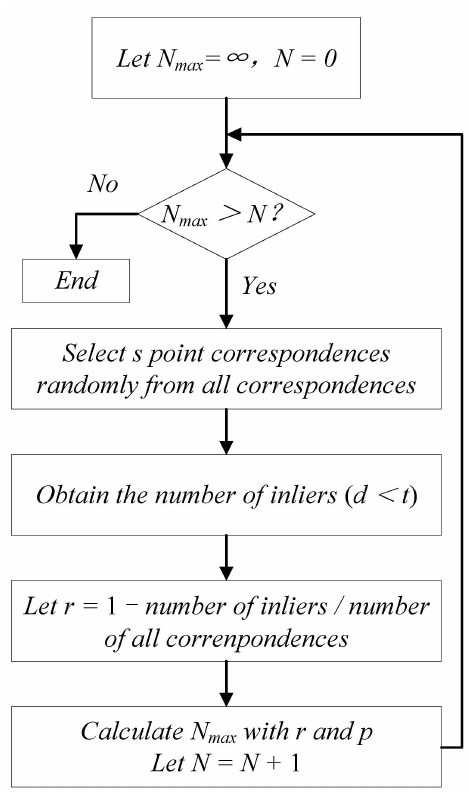
Figure 2. Process flow of